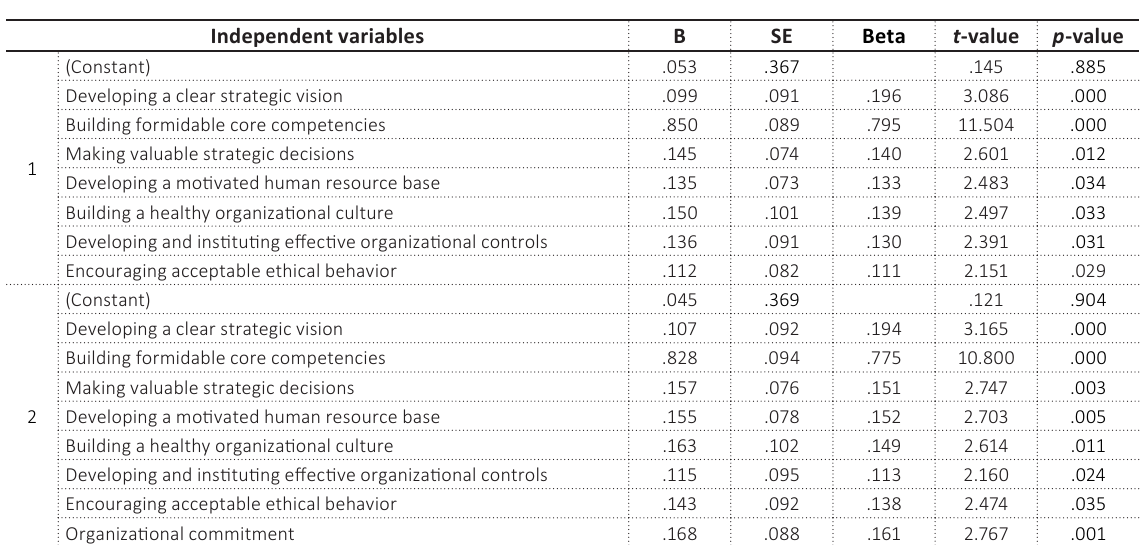
Table 9. Hierarchical regression